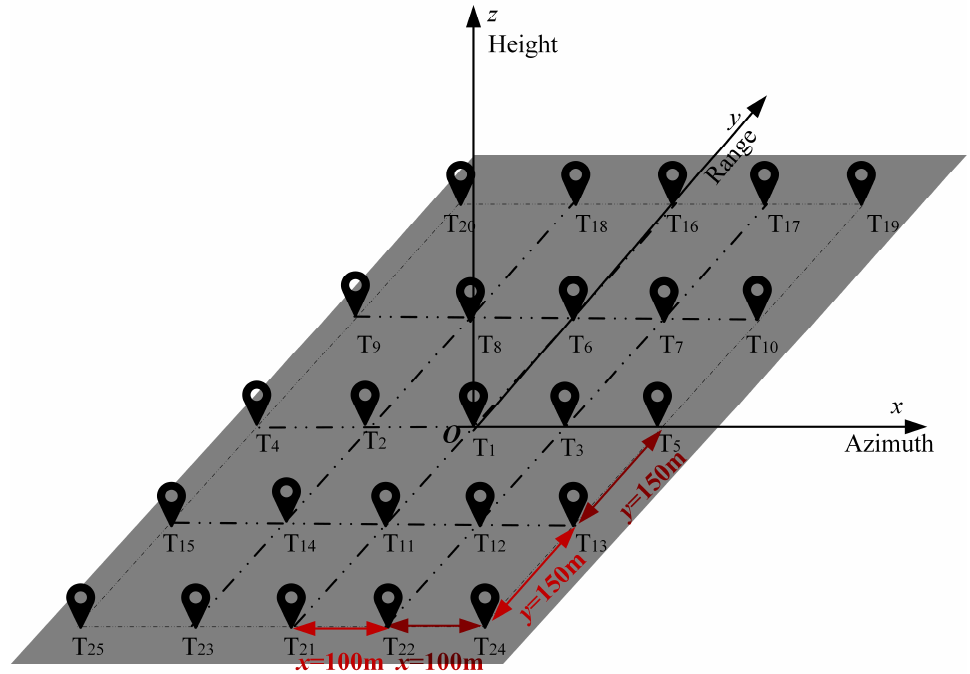
Figure 4. Positions of the 25-point targets in the imaging region.